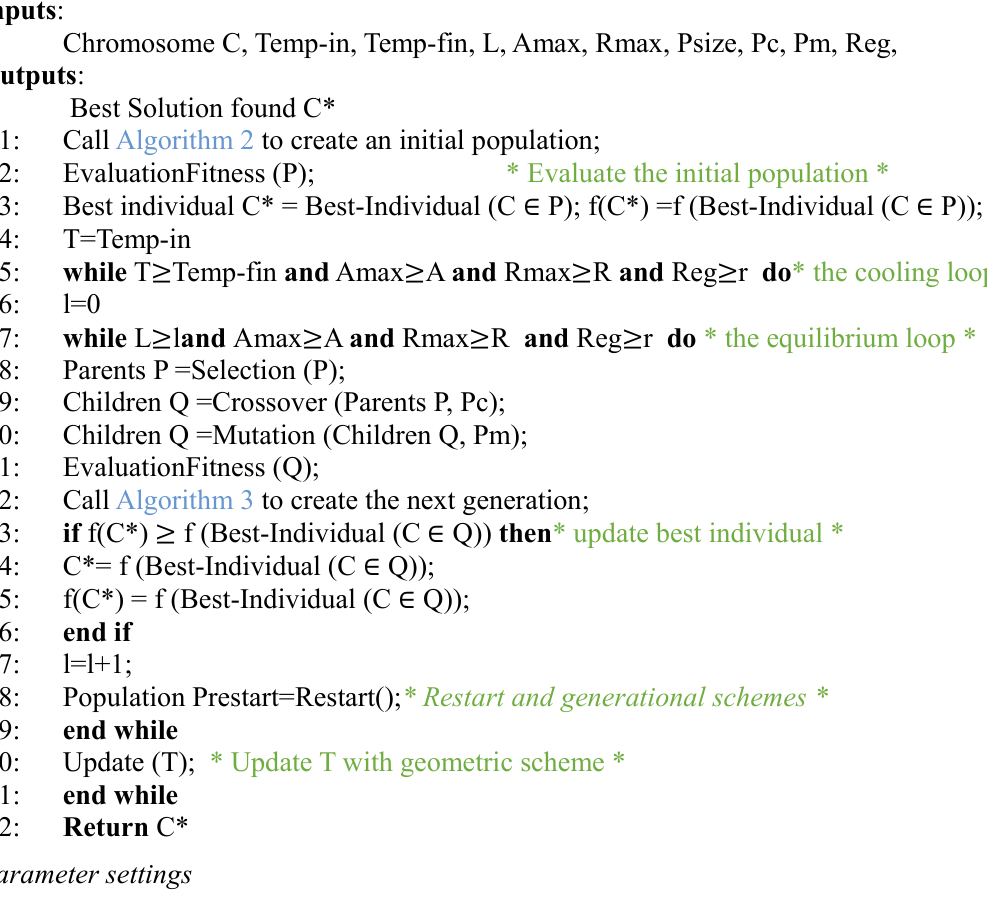
Algorithm 5. Restart and generational scheme: